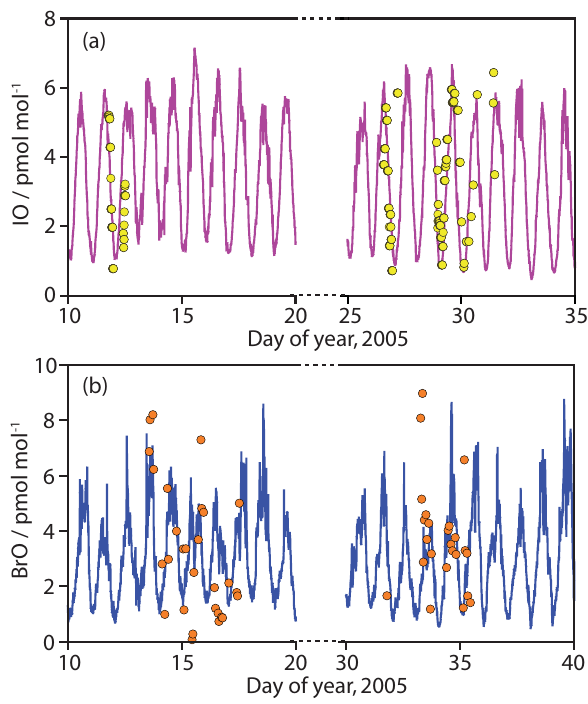
Fig. 1. (a) Observed and modelled IO and (b) Observed and mod- eled BrO mixing ratios as a function of day of year,